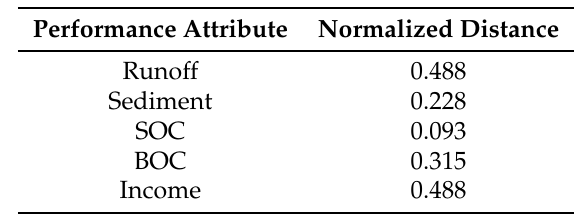
Table 7. Normalized distances to the ideal point corresponding to the optimal distribution of trajectories produced by BIOLP for the reference